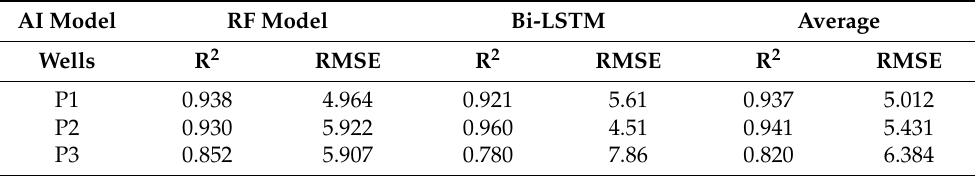
Table 6. R 2 and RMSE for cross-well prediction.